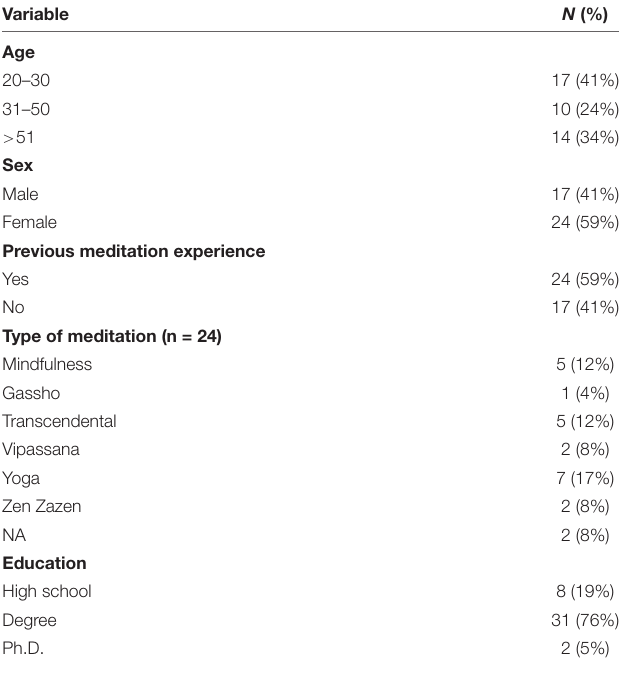
TABLE 1 | Baseline characteristics of the